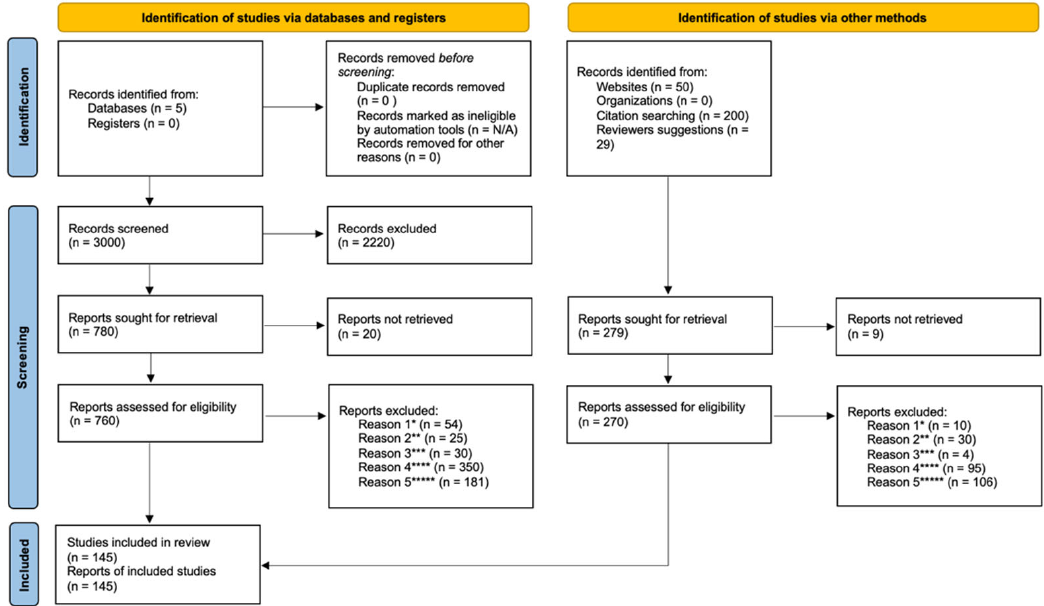
Figure 1. Flow diagram of the systematic review. * Experimental work not confirmed in humans; ** Neurorehabilitation propositions difficult to generalize; *** Theoretical knowledge difficult to ex ‐ trapolate; **** Works with too small sample size; ***** Works with very low quality evidence of improvement.